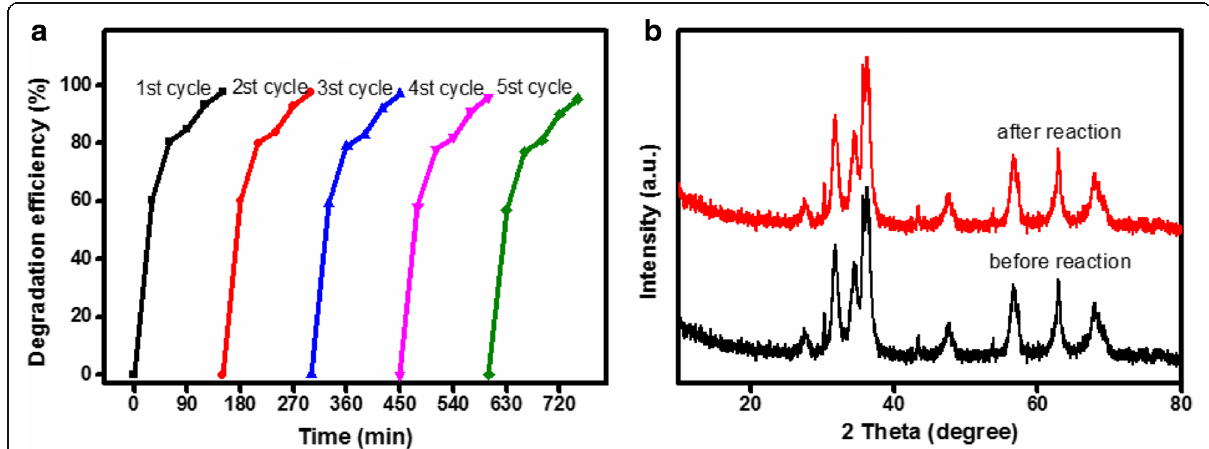
Fig. 10 The recycling degradation efficiency ( a ) and XRD patterns of before and after degradation ( b ) of ZnO/Fe 3 O 4 /g-C 3 N 4 -50% for MO under visible light